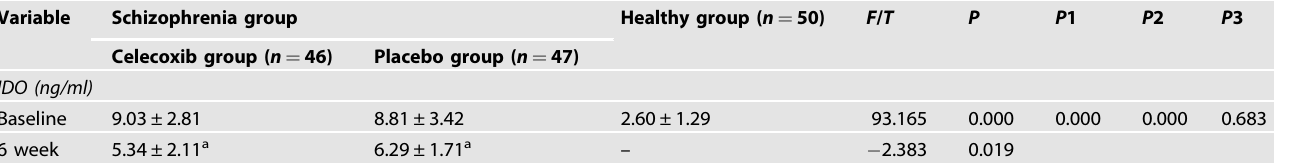
Table 2. Treatment outcome of IDO for different subgroups of patients and healthy group.